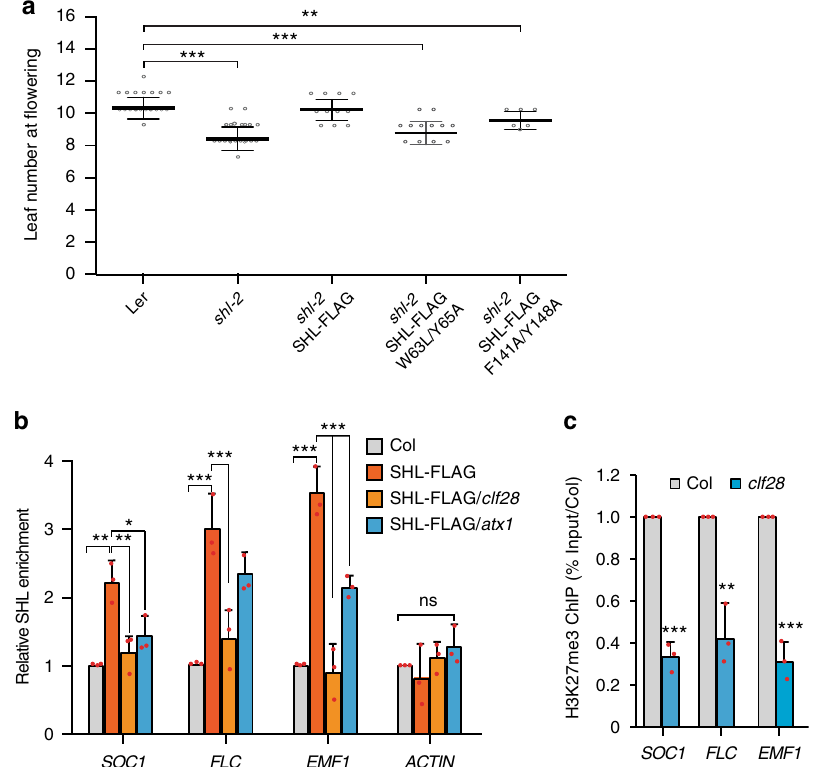
Fig. 6 BAH and PHD are important for SHL function in vivo. a Flowering time analysis of long-day grown plants of wild-type L er , shl-2, shl-2 mutants transformed with SHL-FLAG constructs encoding wild-type SHL (SHL-FLAG), H3K27me3 (SHL-FLAG W63L/Y65A) or H3K4me3 (SHL-FLAG F141A/ Y148A) binding defective mutants. Each white circle of the SHL-FLAG, SHL-FLAG W63L/Y65A, and SHL-FLAG F141A/Y148A represents individual T1 transgenic plant. Black horizontal lines are mean and the error bars represent mean ± SD from the number of plants (range of 5-20 plants) counted for each line. b Relative SHL enrichment in wild-type, clf28 , and atx1 mutants. c ChIP-qPCR of relative H3K27me3 levels in Col and clf28 at three loci. Error bars represent mean ± SD from three independent experiments. Red dots denote the individual data points. Student ’ s t -test was used to calculated the P value. * P < 0.05; ** P < 0.01; *** P < 0.001; ns, not signi fi